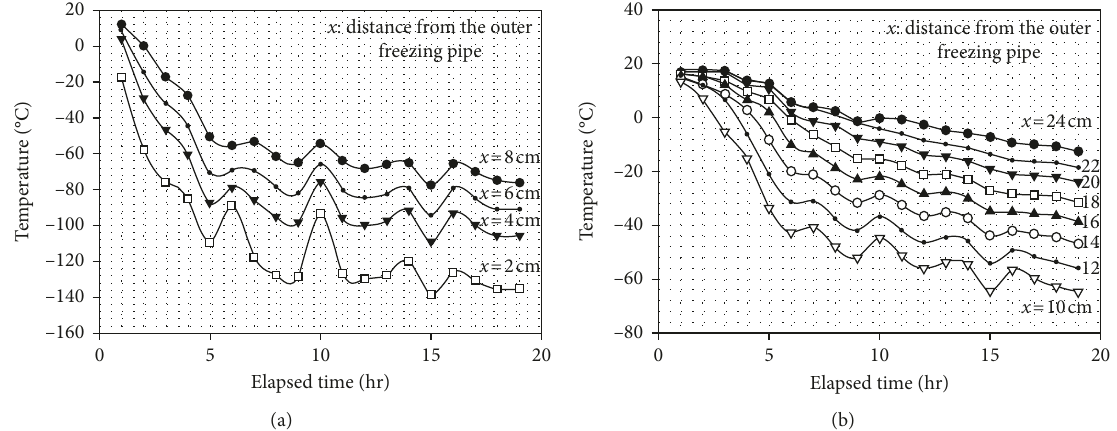
Figure 6: Temperature with elapsed time at various locations from the freezing pipe.